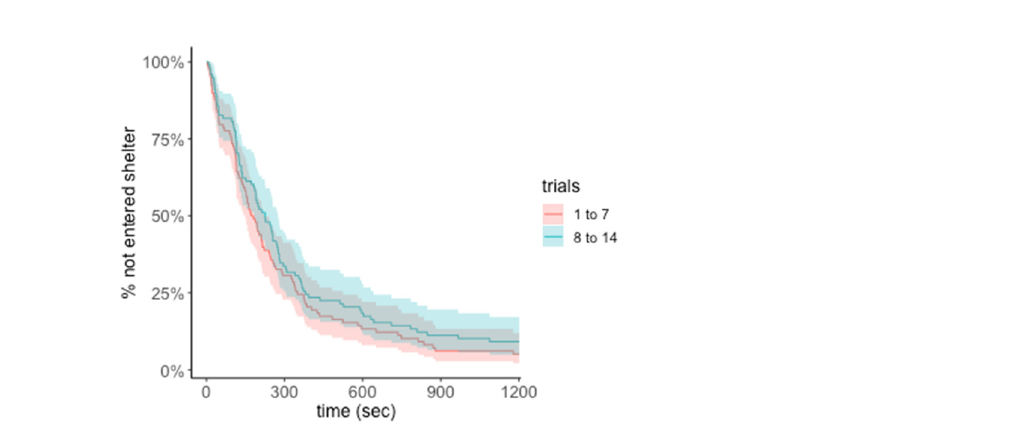
Figure 3. Cox proportional-hazards model of time to success for Experiment 1—Within modality ‘sameness’ assay. Survival curves for time to enter correct shelter with 95% confidence intervals. Curves represent early trials (1 to 7) and late trials (8 to 14). Trials were completed at 1200 s. Table 1. Model results for Experiment 1—within modality ‘sameness’ assay. All models were cre- ated with behavioral data from training trials. ∆ AIC is the difference between the AIC of the model with and without trial number as a predictor. Positive ∆ AIC indicates the model shown had a higher AIC value and is a worse model fit than the model without trial number. Including trial number in these models did not significantly improve model fit, indicating P. marginemaculatus did not im- prove over training trials .